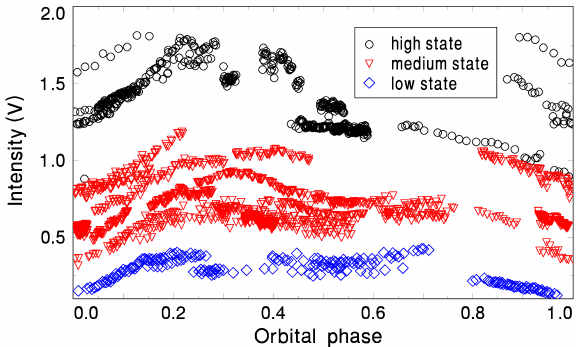
Figure 3: Photoelectric and CCD observations of V Sge in the intensity scale, folded with the orbital phase (the orbital ephemeris of Smak 1995). The sort- ing into three groups is marked. Adapted from ˇSimon et al.